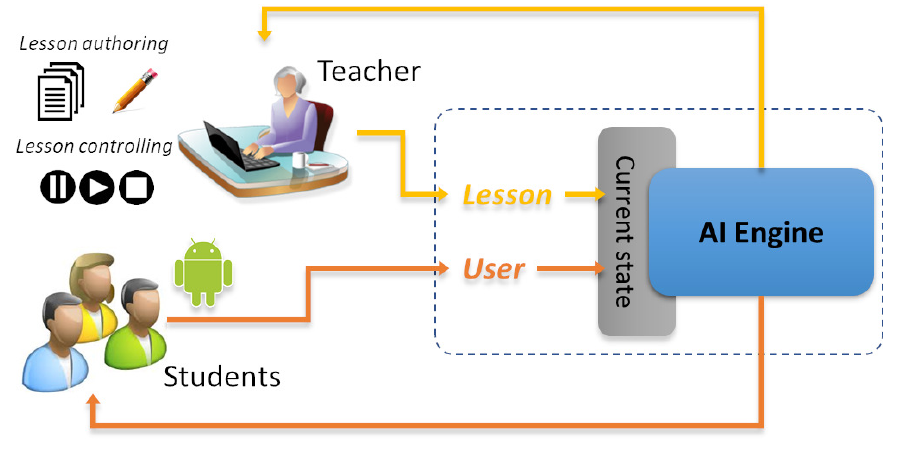
Figure 1. The E X PL O RAA general